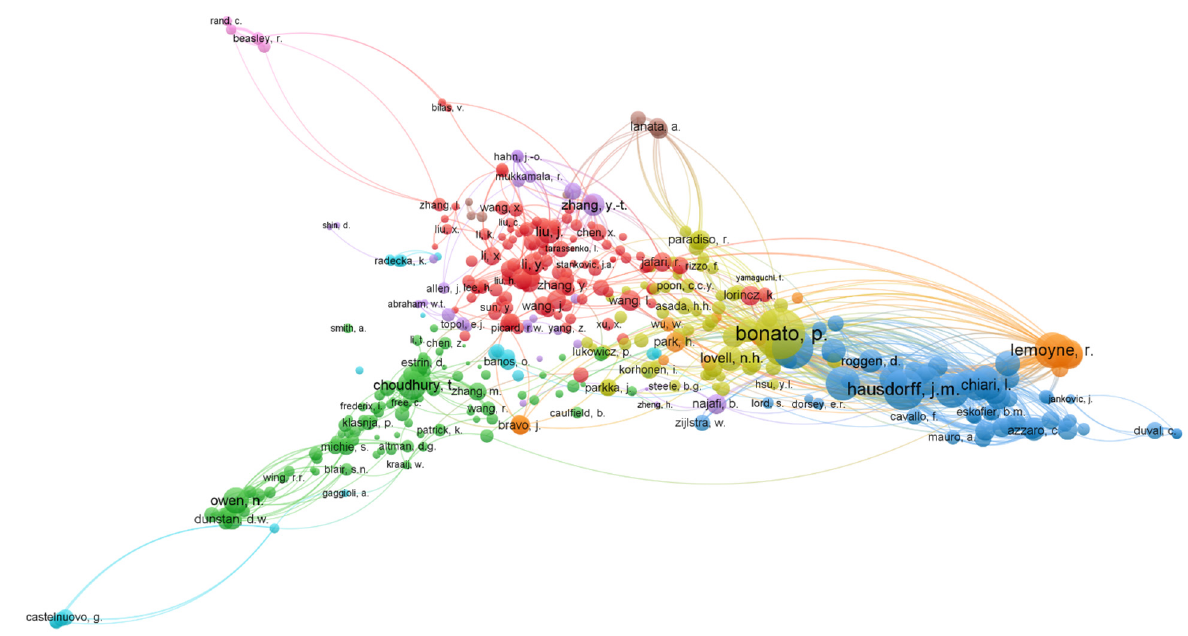
Figure 7. Cluster view of co-cited authors active in the research field of WTH. Each color represents the strongest collaborative networks between authors. The size of the circles is related to greater or lesser co-citation.